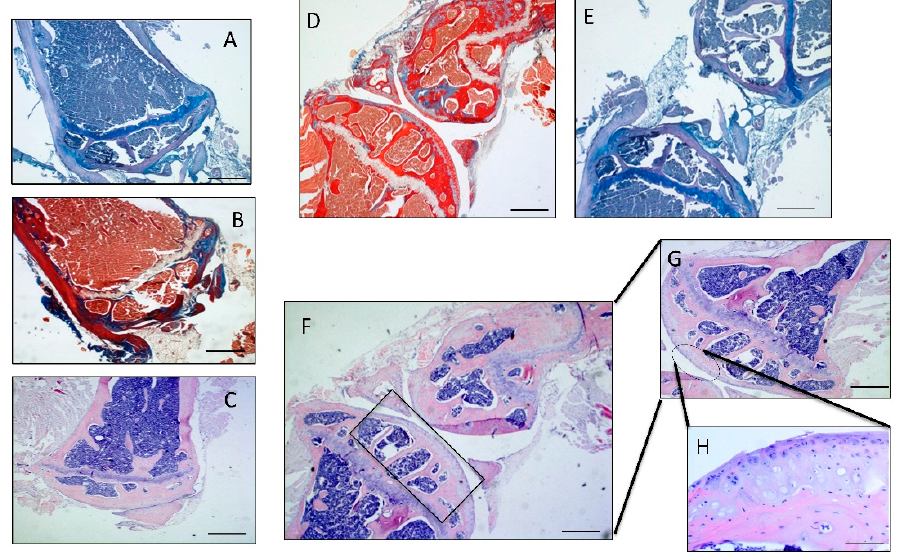
Figure 9. ( A ) Micrograph of the OA distal epiphysis of the femur stained with Toluidine Blue, Magnification ×10; ( B ) Micrograph of the OA distal epiphysis of the femur stained with Masson’s Trichrome, Magnification ×10; ( C ) Micrograph of the OA distal epiphysis of the femur stained with Hematoxylin and Eosin, Magnification ×10; ( D ) Micrograph of the OA knee joint stained with Masson's Trichrome, Magnification ×5; ( E ) Micrograph of the OA knee joint stained with Toluidine Blue, Magnification ×5; ( F ) Micrograph of the OA knee joint stained with Hematoxylin and Eosin, Magnification ×5; ( G ) Magnification of J ×10; ( H ) Magnification ×20, Scale bars: 100 µm.